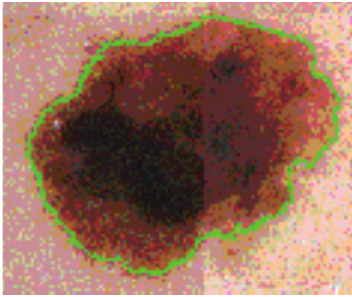
Figure 3: A segmentation example.